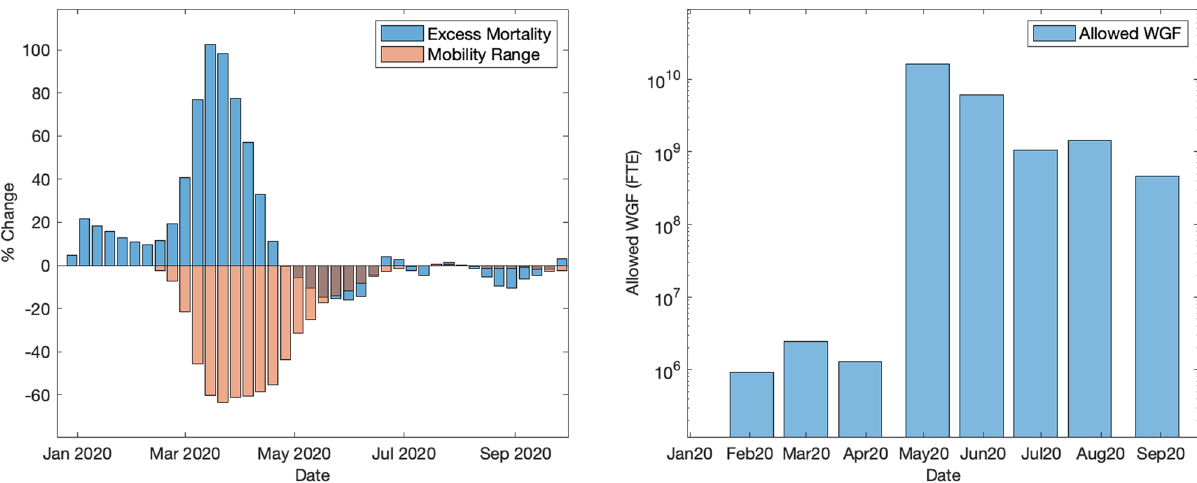
Figure 1. Wage Guarantee Fund, excess deaths and mobility range over time. The subplot on the left displays the average number of excess deaths per week and weekly average mobility changes. The subplot on the right shows the trend over time of the monthly average amount of allowed working hours covered by the Wage Guarantee Fund. The two-week moving average is reported for excess deaths and mobility